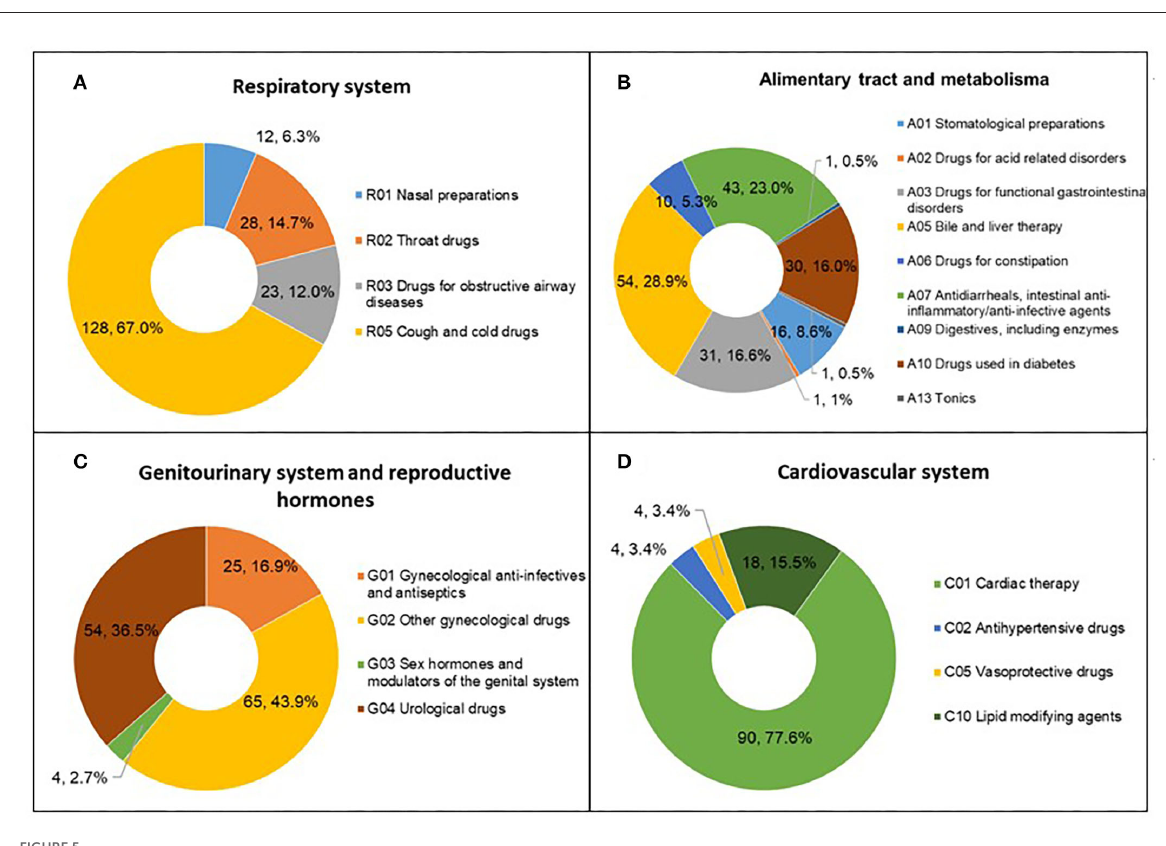
FIGURE5 Subclass distribution of TCM trials registered from 2013 to 2021 in mainland China. (A) Respiratory system; (B) Alimentary tract and metabolism; (C) Genitourinary system and reproductive hormones; (D) Cardiovascular